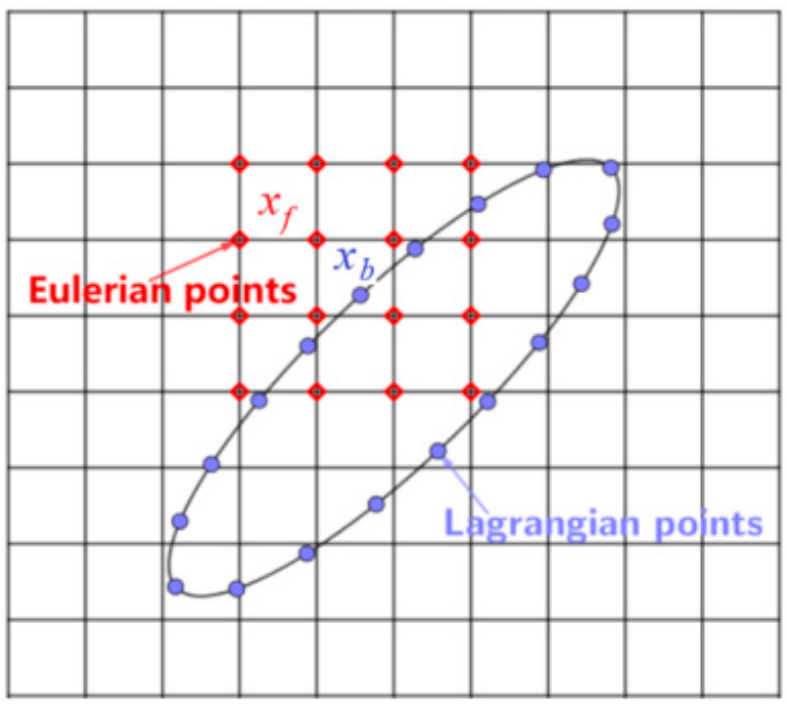
Figure 1. Schematic of the Eulerian and Lagrangian grids. D is used to establish the connection between the fluid and the immersed